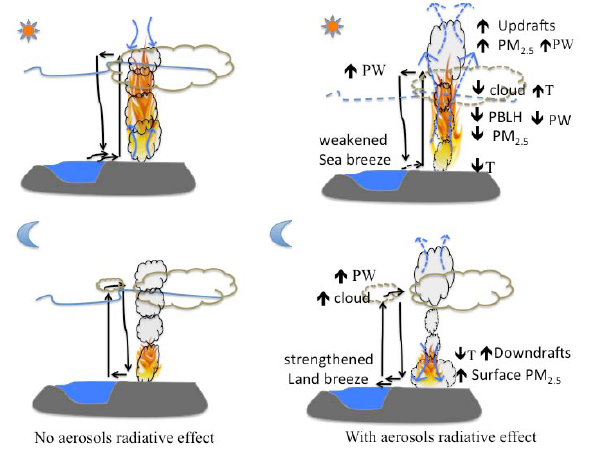
Fig. 11. A conceptual model that illustrates the radiative effect of smoke aerosols on the change of aerosol concentration, PBLH, wind, and cloud fraction over the Southeast Asian Maritime Con- tinent. ↑ denotes increase, and ↓ denotes decrease. See the text in Sect. 5 for